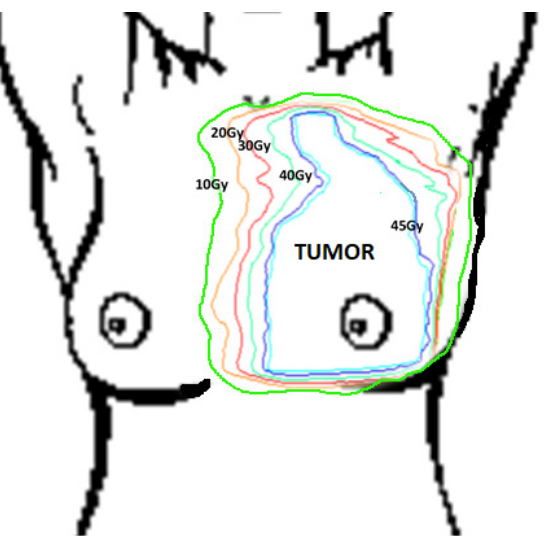
Figure 1. The scheme of drawing the isodoses on all thermograms with marked regions of interest (isodoses 10–45 Gy). Isodoses were obtained from the treatment planning system and were reflected on the thermal images.